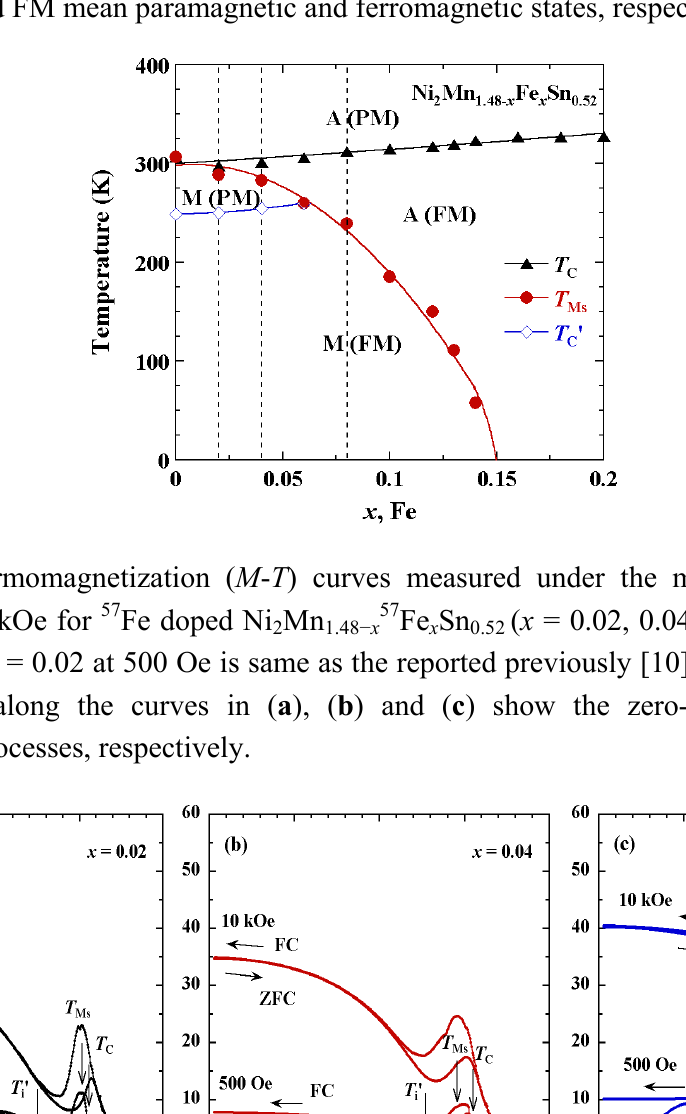
Figure 1. Phase diagram of Fe substituted Ni Fukushima et al . [13]. A and M indicate the austenite and martensite phases, respectively. T and T ' indicate the Curie temperature of the austenite phase and the martensite phase, C C means the martensitic transformation starting temperature during cooling respectively. T Ms process. PM and FM mean paramagnetic and ferromagnetic states, respectively.